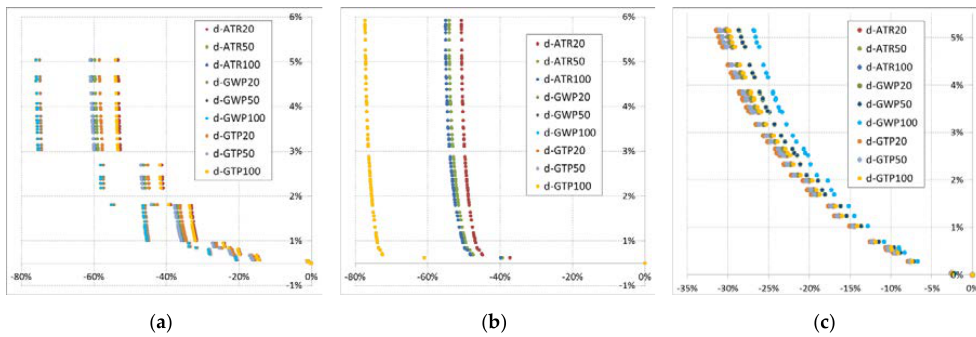
Figure 4. Pareto front on climate impact reduction vs. fuel increase (%) for different climate metrics, using the routes optimized using ATR 20 : Lulea–Gran Canaria ( a ), Helsinki–Gran Canaria ( b ), and Baku–Luxembourg ( c ).